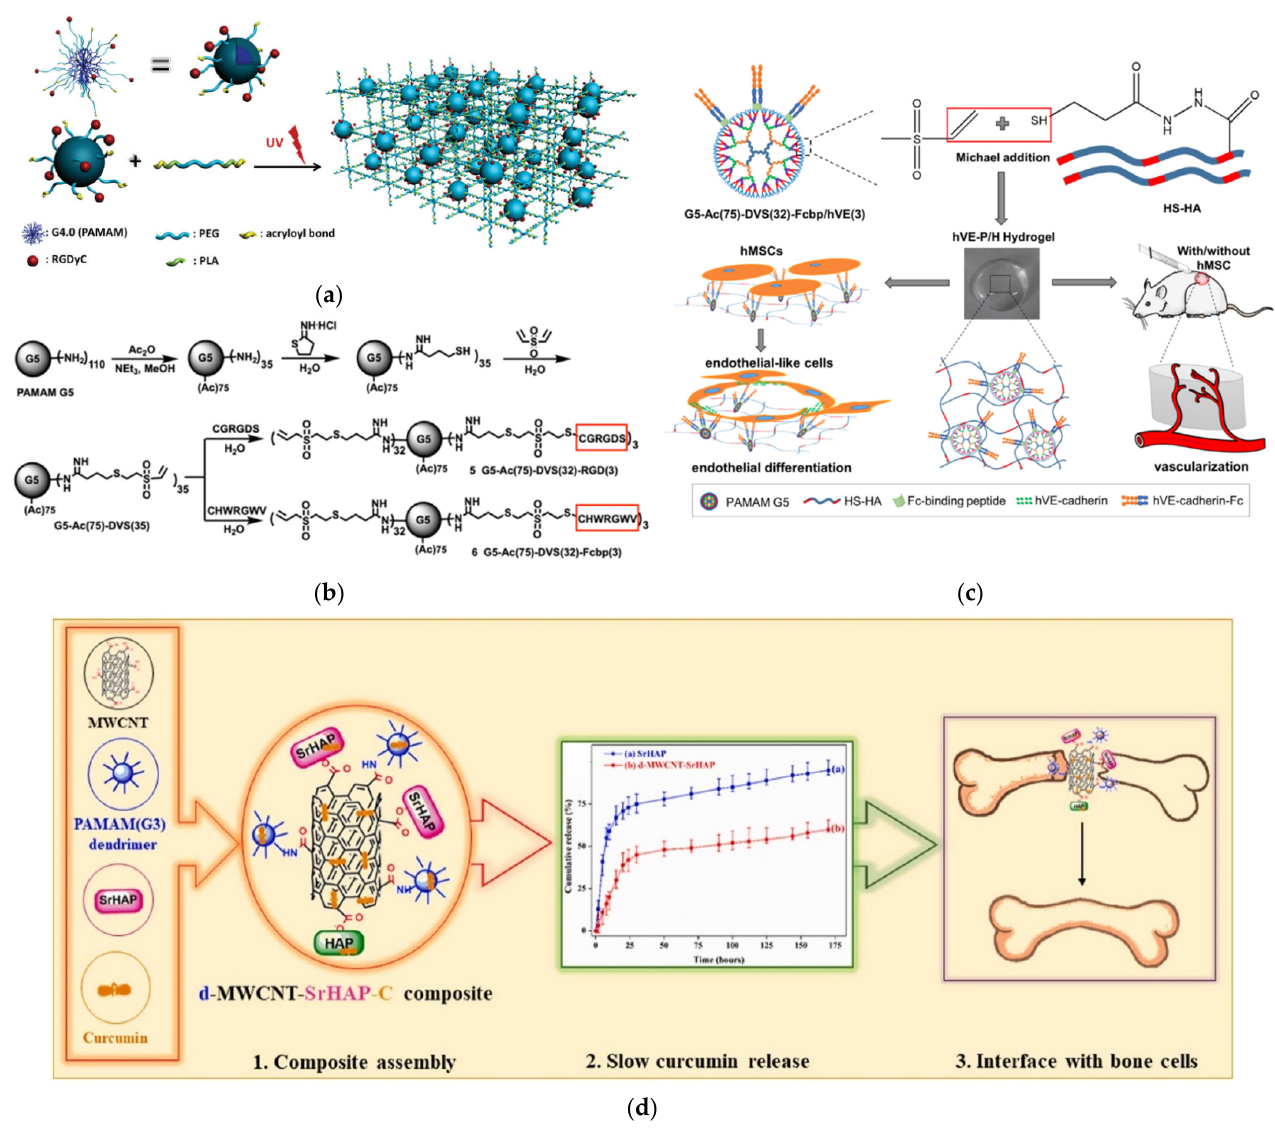
Figure 17. ( a ) Schematic representation of the hydrogel derived from functionalized dendritic G4 PAMAM and linear PEG. Reproduced with permission from [194]. Copyright: WILEY-VCH Verlag GmbH & Co. KGaA, Weinheim ( b ) Synthesis of the functionalized PAMAM dendrimer. ( c ) Preparation of the G5 PAMAM-thiolated hyaluronic acid hydrogel and endothelial differentiation of human umbilical cord mesenchymal stem cells and vascularization in vitro and in vivo. Both were reproduced with permission from [196]. Copyright: Elsevier Ltd. ( d ) Schematic representation of 1. composite assembly. 2. Curcumin release from the composite in comparison to strontium-substituted HAP 3. Osseointegration of the hybrid material with the damaged bone. Reproduced with permission from [197]. Copyright: Elsevier Ltd. and Techna Group S.r.l.